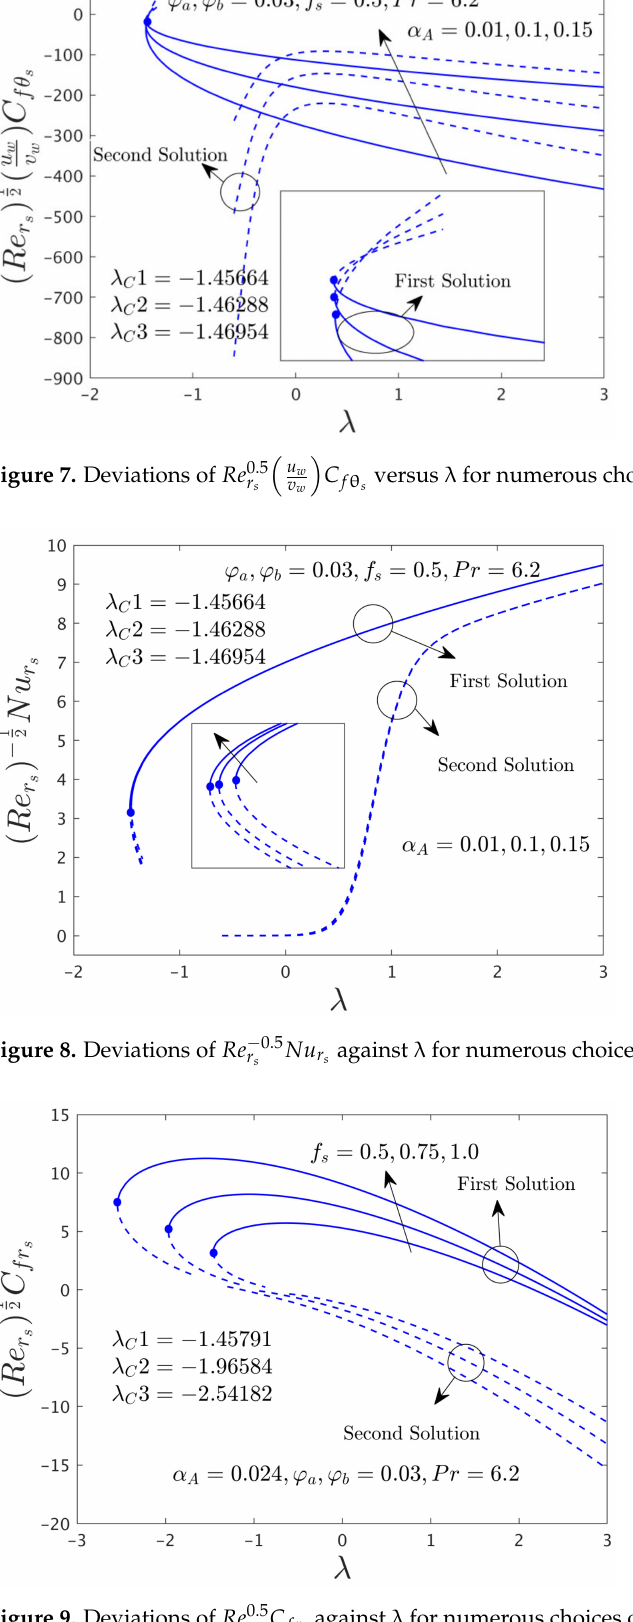
Figure 9. Deviations of Re 0.5 r